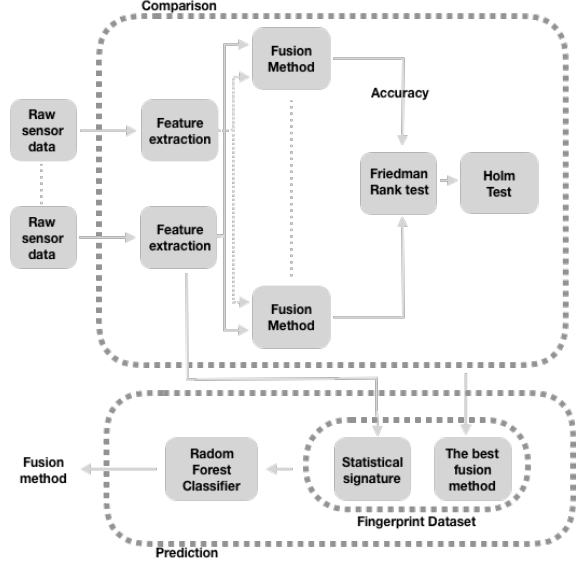
Figure 4. Overview of the optimal fusion method prediction